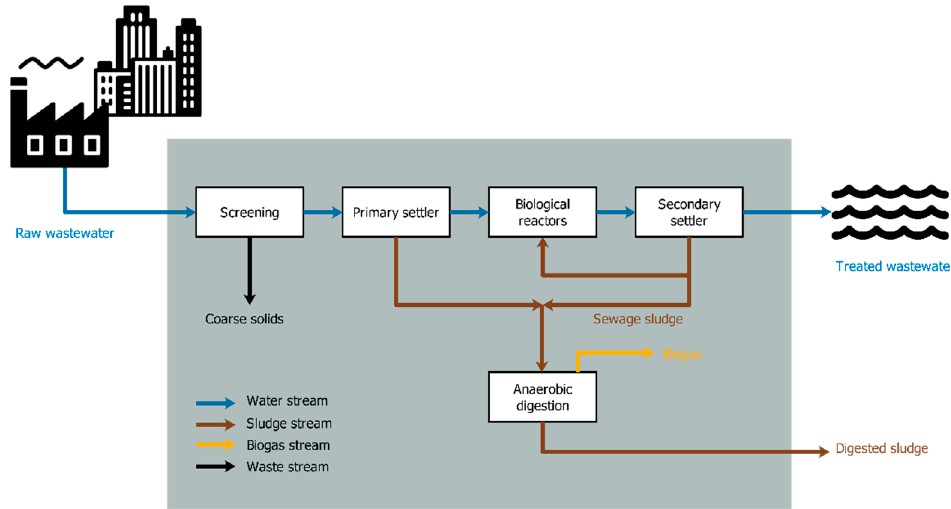
Figure 1. Simplified functional scheme of a WWTP.